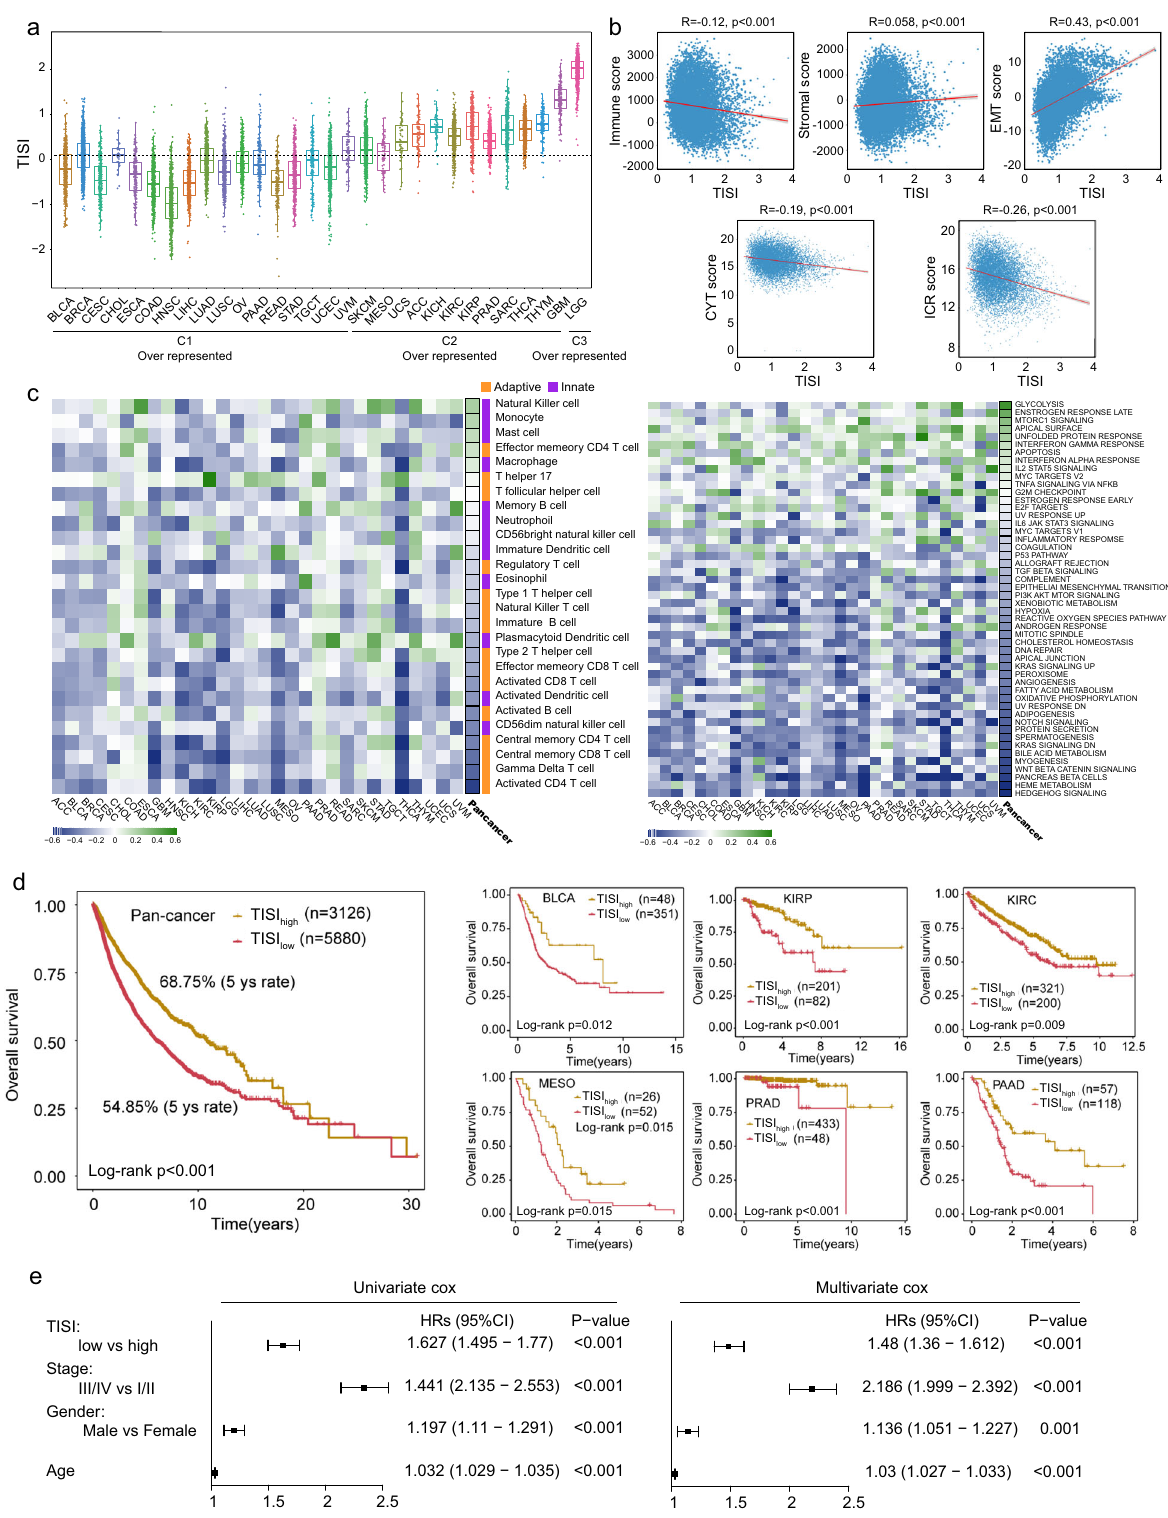
Fig. 3 Development and validation of the TISI in pan-cancer. a Distribution of TISI in different cancer types. The dotted line represents the median TISI in all samples. b Correlation between cancer-related events and the TISI. c Association of the in fi ltration status of different immune cell populations and cancer hallmark pathways with the TISI. d Pan-cancer and cancer-speci fi c Kaplan – Meier survival curves of tumor patients between TISI high and TISI low groups. The P -value was calculated by the log-rank test. e Univariate and multivariate analysis of the TISI with other standard clinical features in the pan-cancer. P -value was calculated by the Cox proportional hazard model. lncRNA long noncoding RNAs, TISI TIL-lncRNA-derived immune state